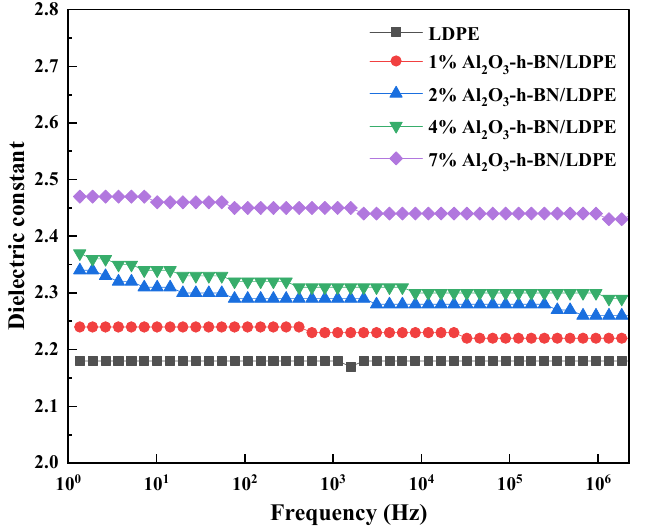
Figure 4. Plot of dielectric permittivity of LDPE and its nanocomposite specimens at room temperature. Figure 5 shows the relationship between the dielectric loss and frequency of LDPE and Al 2 O 3 -h-BN/LDPE composite samples. Adding nanofillers increased the dielectric loss [14], but the dielectric loss was only 0.0074 higher than that of the pure LDPE when the doping content was 7 wt% by weight. The dielectric loss of the pure LDPE and nanocomposite films doped with different contents initially decreased and then increased with increased frequency from 10 to 10 6 , and the difference in the dielectric loss at 10 5 Hz was the smallest, i.e., only about 0.001. Apparently, the dielectric loss of the composite was only slightly affected by the h-BN and Al 2 O 3 fibers. So, the application of its insulating properties in cables was hardly affected. Dielectric loss mainly includes conductance loss and polarization loss. At low frequency, the electric field changes slowly, and the polarization of dielectric material is basically synchronous with the change of the external electric field, so the polarization loss is low. However, at high frequencies, the polarization of the polymer film cannot synchronize with the change of the applied electric field, and the dipole composed of positive and negative charges will tend to align along the direction of the electric field, and gradually begin to rotate to produce a polarization loss [15].